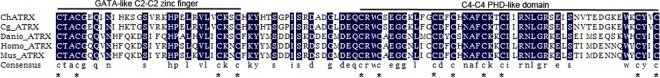
Amino acid sequence alignment of the ADD domain from C.hongkongensis ATRX ortholog with vertebrate ATRX.The highly conserved C2-C2 zinc finger and C4-C4 zinc finger are indicated by asterisks.